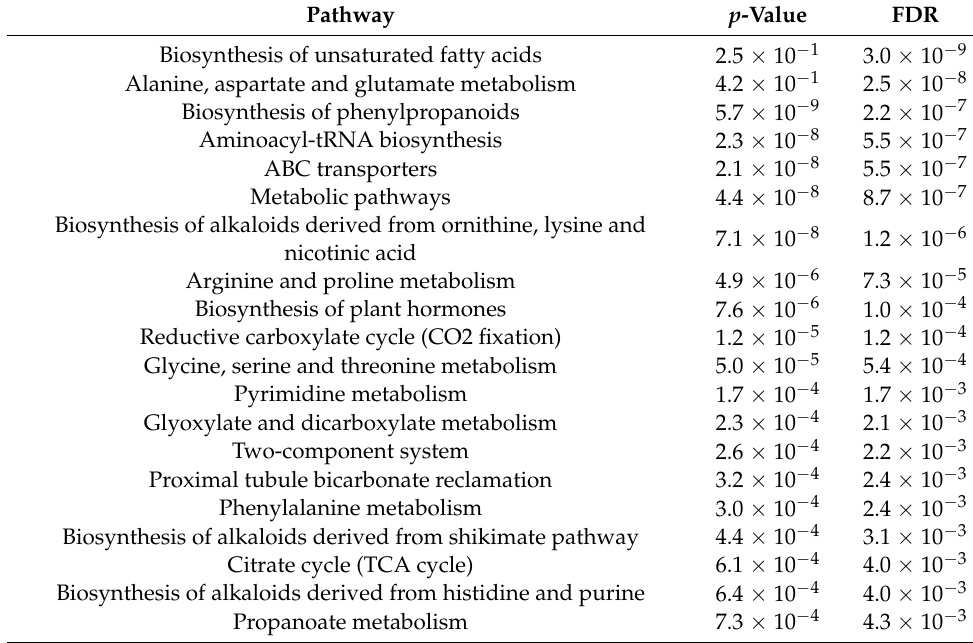
Table 6. Pathway enrichment analysis of differential metabolites in ESI −